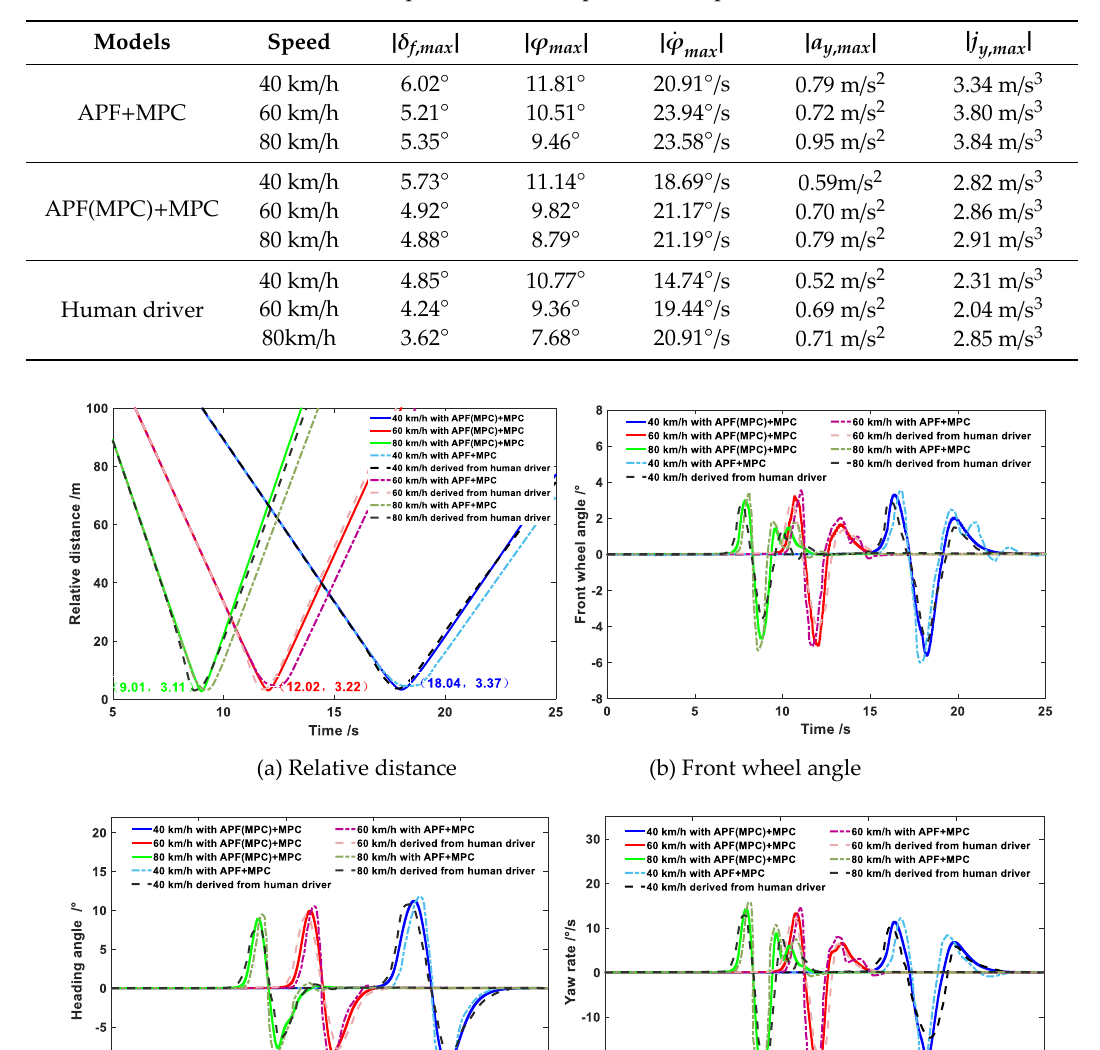
Table 2. Comparison results of performance parameters.